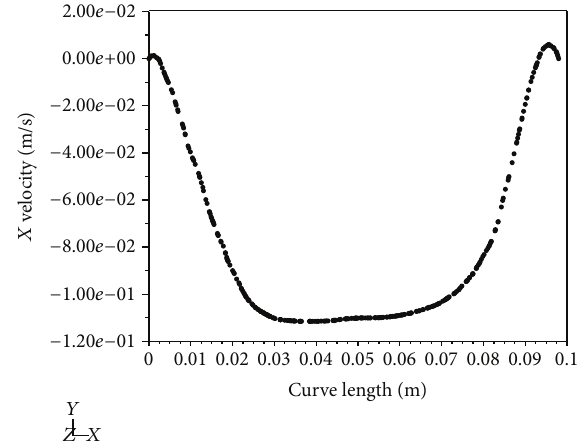
Figure 6: The velocity curve in the 𝑋 direction along AB.